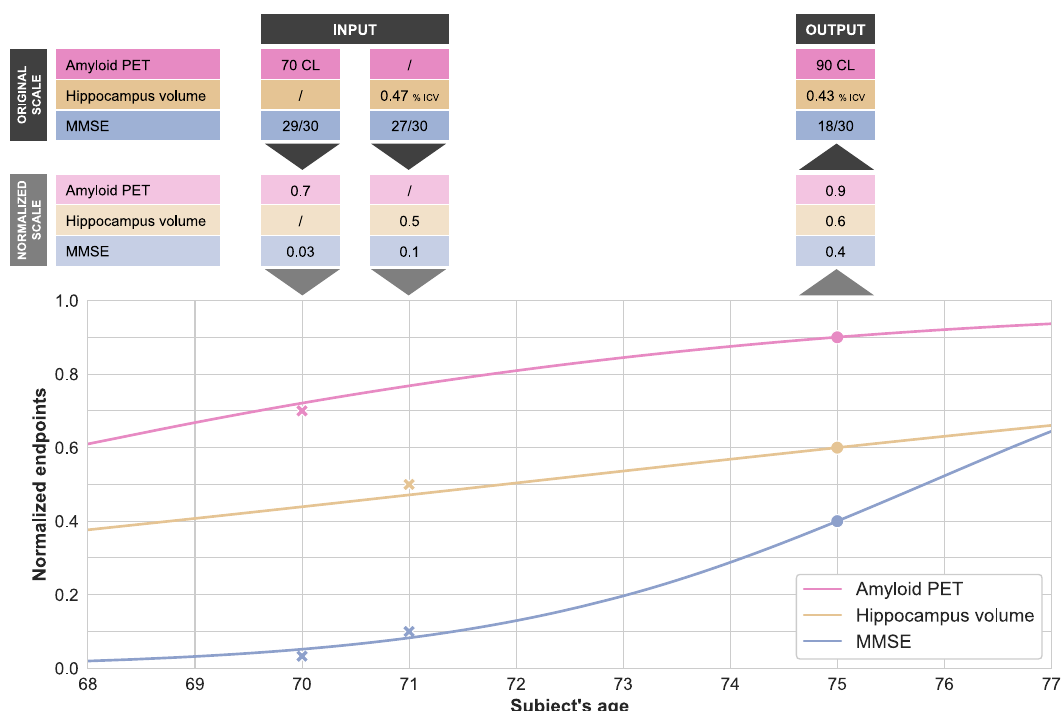
Fig.1| Diseaseprogressionmodelsforecasttheprogressionofendpointsfrom historical data of a participant. In this simpli fi ed example, the model has only three endpoints (Amyloid PET, Hippocampus volume, and mini-mental state examination (MMSE)). The participant has been observed twice at 70 and 71 years old (colored crosses). After normalizing the data to a 0 – 1 scale (0 being the most normal and 1 the maximum pathological change), the model predicts the